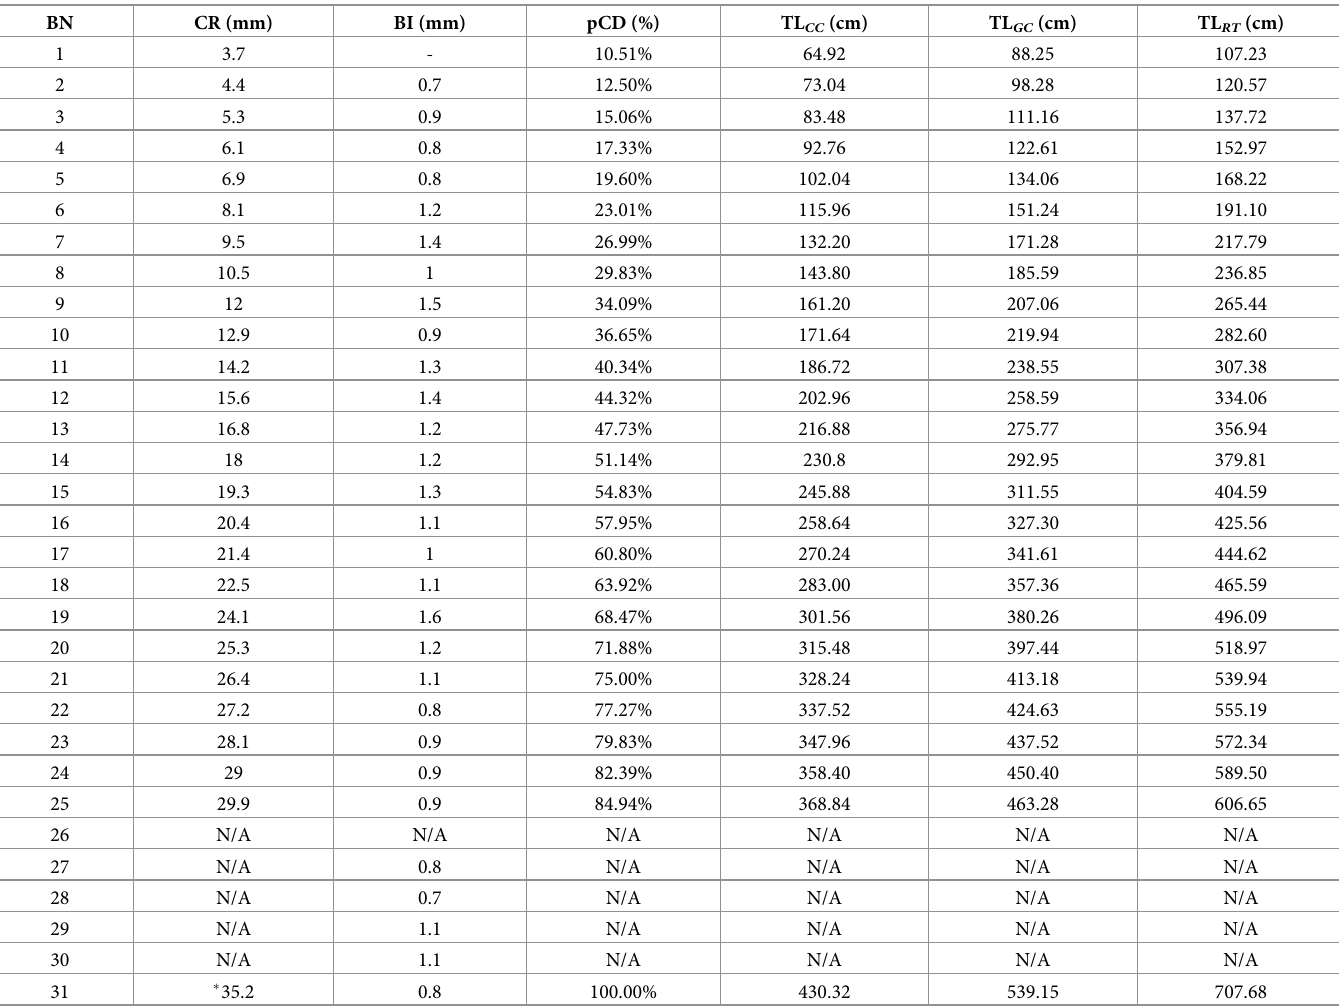
Table 1. Measurements and derived estimations taken from vertebra